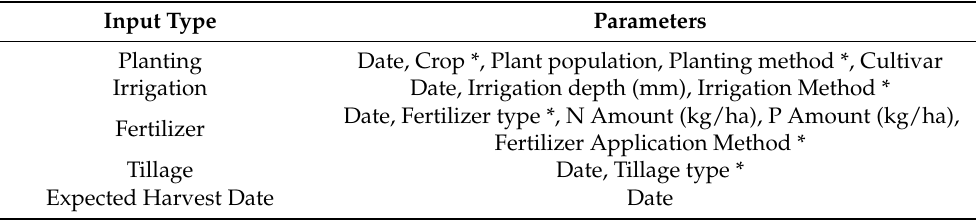
Figure 4. Management practices definition. Table 5. Input type and parameters for FARMs.